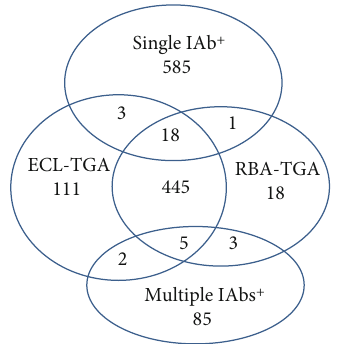
Figure 4: TGA positivity by ECL and RBA and its relationship with islet autoantibodies (IAbs) on 23,319 children screened in general population. Only small proportions of TGA (32/606, 5.3%) and IAbs (32/702, 4.6%) were overlapped between. The overlap of TGA with multiple IAbs was signi fi cantly higher than that with single IAb (10.5% (10/95) vs. 3.6% (22/607), p = 0 : 006